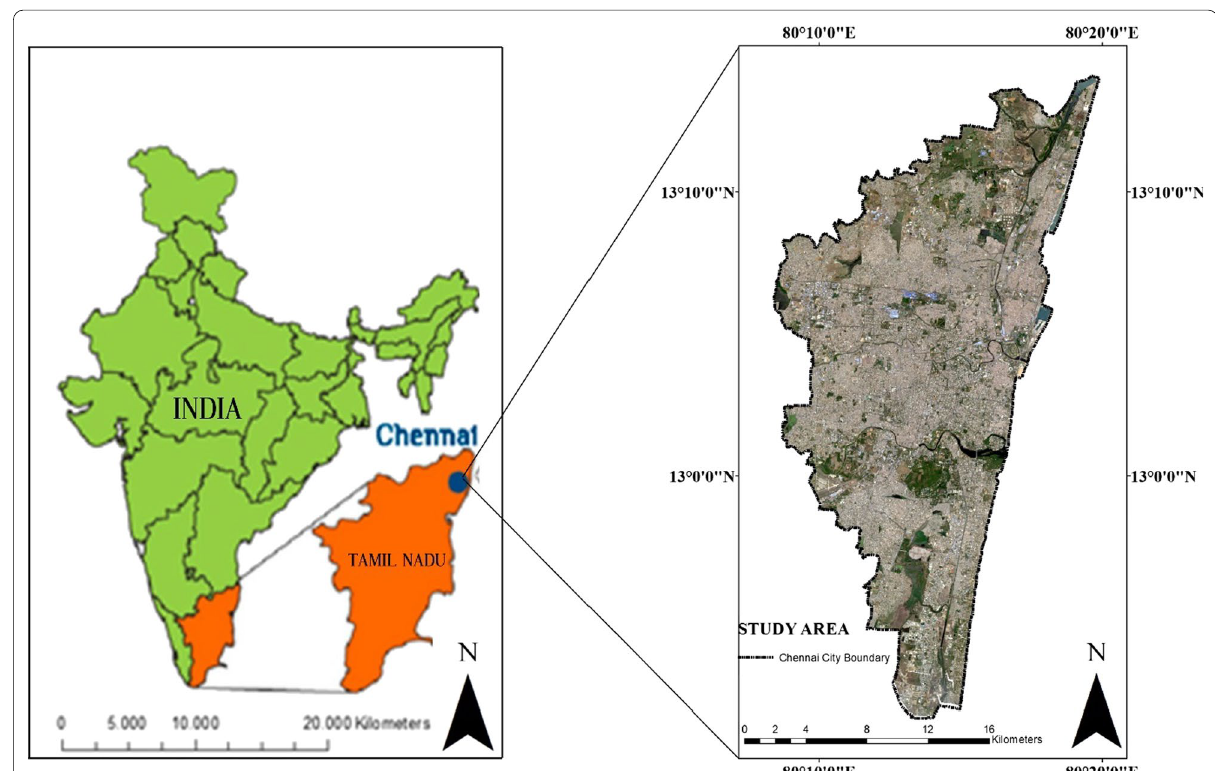
Fig. 1 Location map of